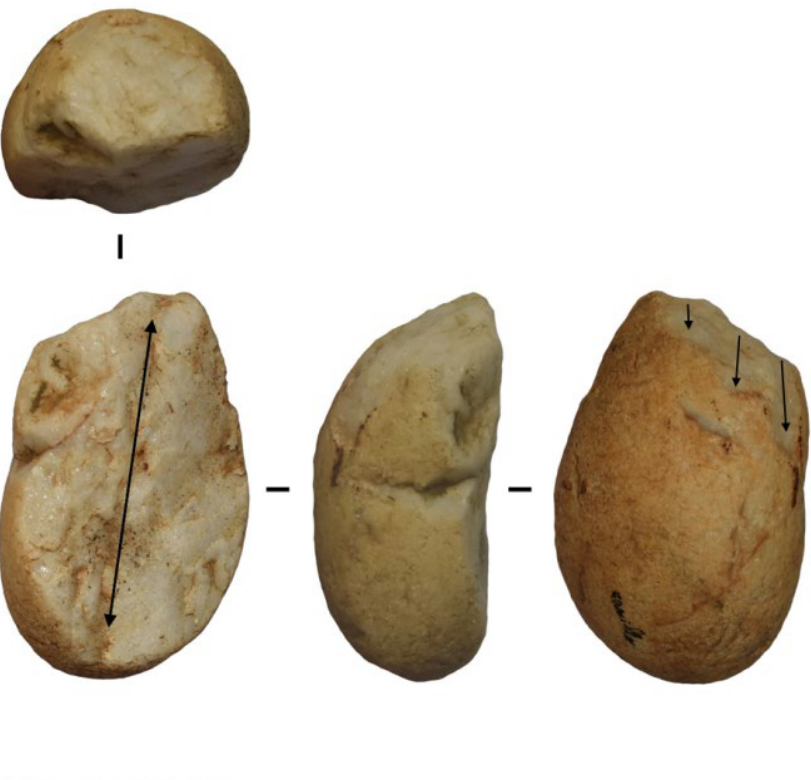
Figure 16. Split-cobble of quartz (bipolar-on-anvil method), shaped subsequently with unipolar removals. Scale bar: 5